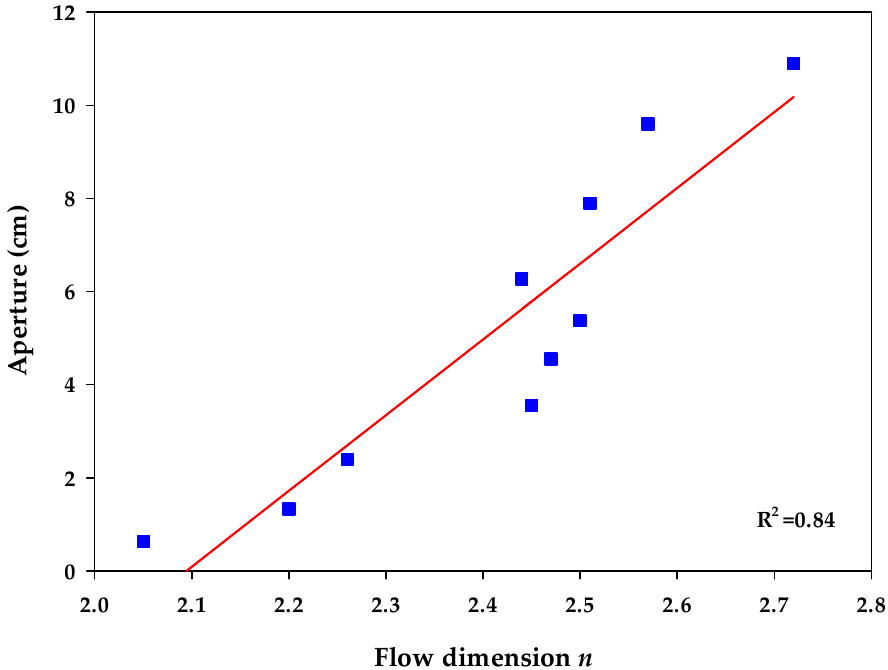
Figure 5. Relationship between n and FA.